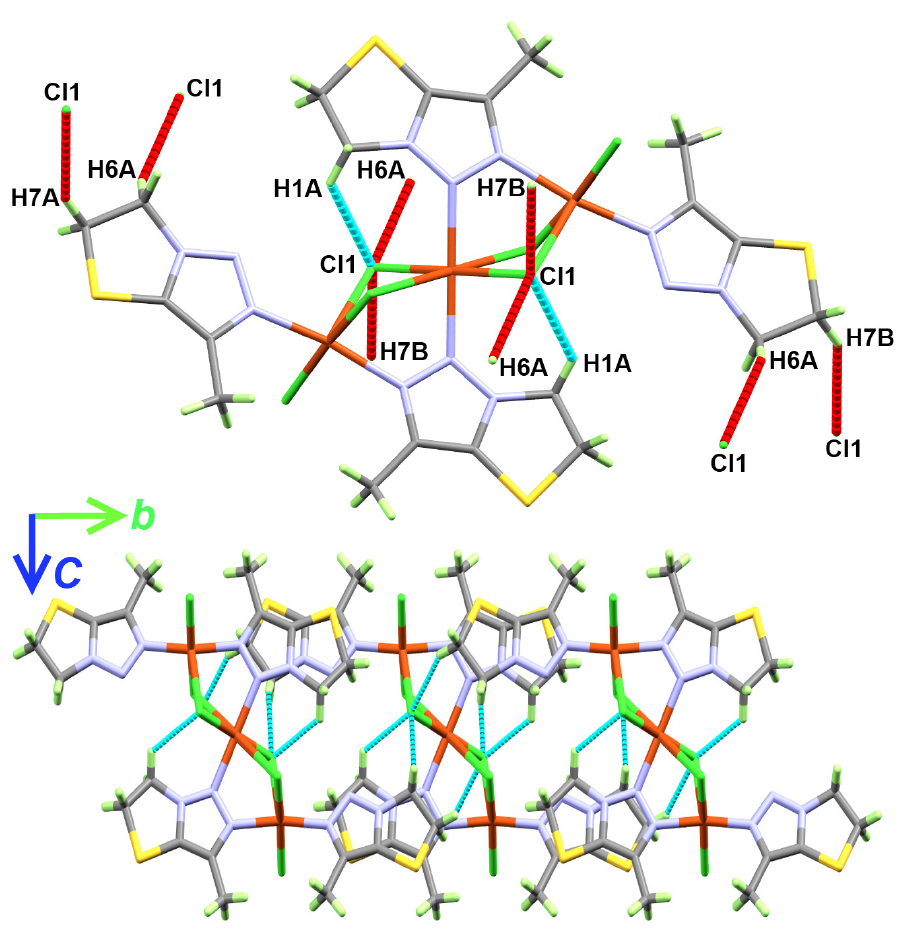
Figure 3. Intra- and intermolecular C-H . . . O contacts ( upper ) and packing scheme along bc plane ( lower ) of the [Cu 3 (L a ) 4 (Cl) 6 ] complex.